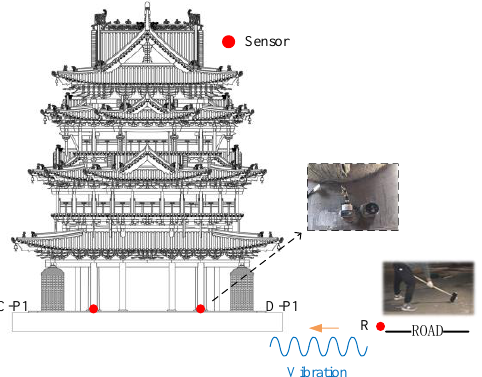
Figure 6. The vertical layout of the measurement points. (Field Test of the RTR Function) The equipment utilized in the test includes an INV3020C synchronous data acquisi- tion system with 28 channels, and 15 uniaxial (10 horizontal and 5 vertical) 941b accelera- tion sensors. Before the test, the acceleration sensors are appropriately calibrated for con- sistency and sensitivity. 2.3.1. Variation of the RTR Function with Excitation Vibration Energy The artificial excitation vibration was applied to the system by using a free − falling weight. By controlling the hammer falling from heights of 50 – 70 cm with an increment of 5 cm, we examined whether the RTR of the system would change due to the same spectral characteristics but with various vibrational energies. Considering that the environmental vibration caused by traffic is mainly low − frequency vibration, we mainly analyzed the vibration below 80 Hz. According to Equations (12) and (13), the RTRs of the system subjected to different levels of the input energy were calculated. For this purpose, at least five sets of valid ham- mer vibration data were collected for each working condition, and the RTR from the vi- bration source replacement point (R) to the first floor measuring point (A − P1, B − P1, C − P1, D − P1) was calculated due to each hammering excitation. Subsequently, the average value of five groups of RTRs in the same direction under the same working condition was taken as the RTR in this direction under this working condition. Taking the horizontal east − west direction (X direction) as an example, the amplitude − RTR and the RMS − RTR under